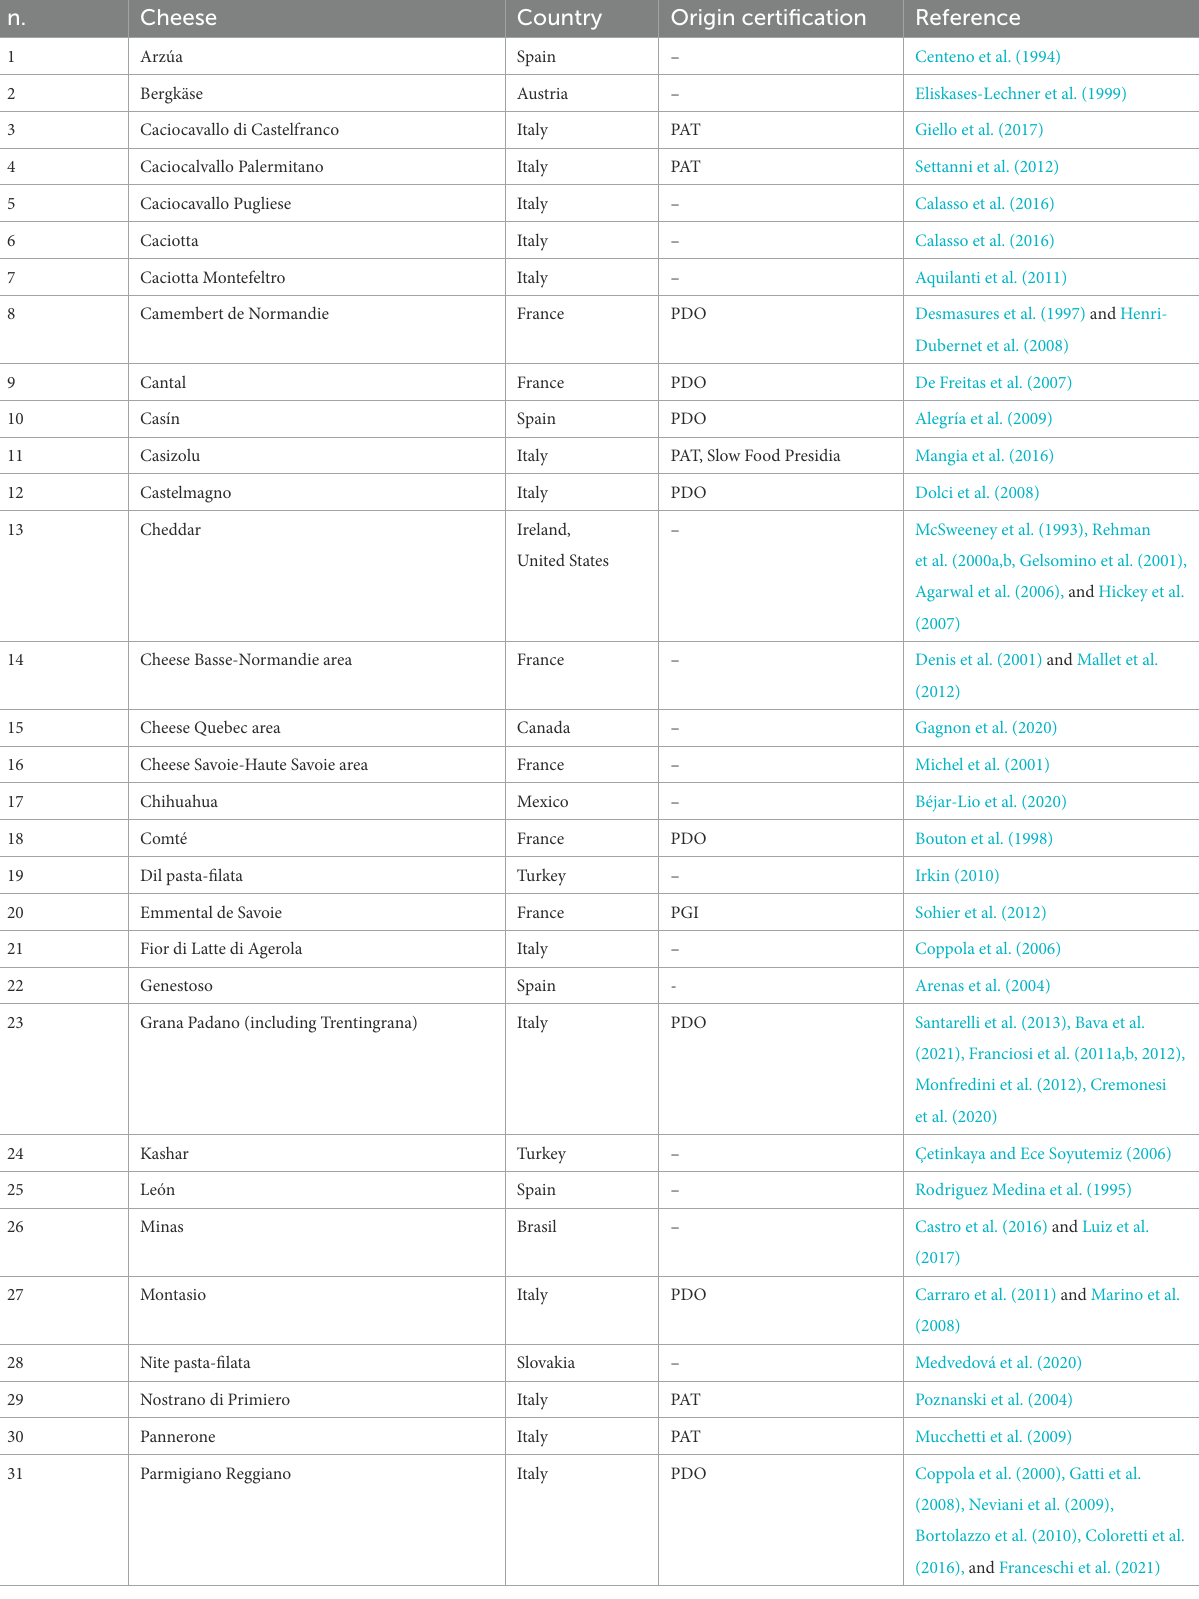
TABLE 1 List of cheeses whose raw milk was analyzed for LAB concentration through culture-dependent techniques.